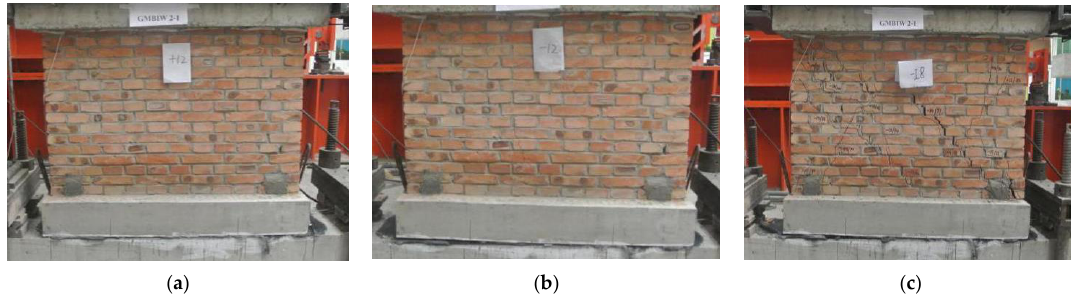
Figure 10. Failure process of GGBW-1: ( a ) slide isolator; ( b ) preliminary cracking; ( c ) specimen failure.